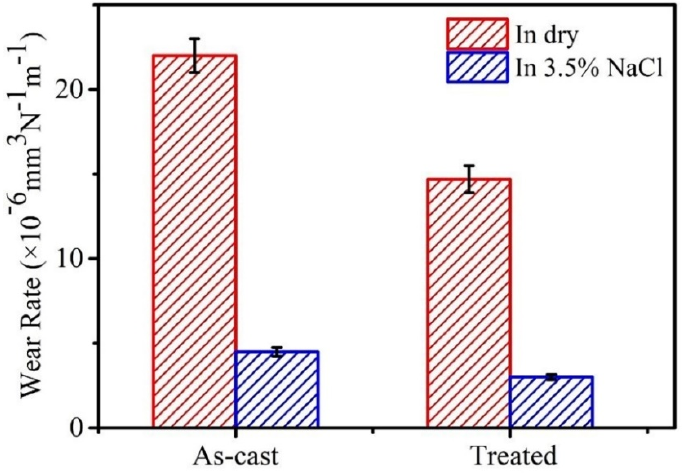
Figure 5. The wear rate of as − cast and treated Zr 54.46 Al 9.9 Ni 4.95 Cu 29.7 Pd 0.99 BMGs in different environments.